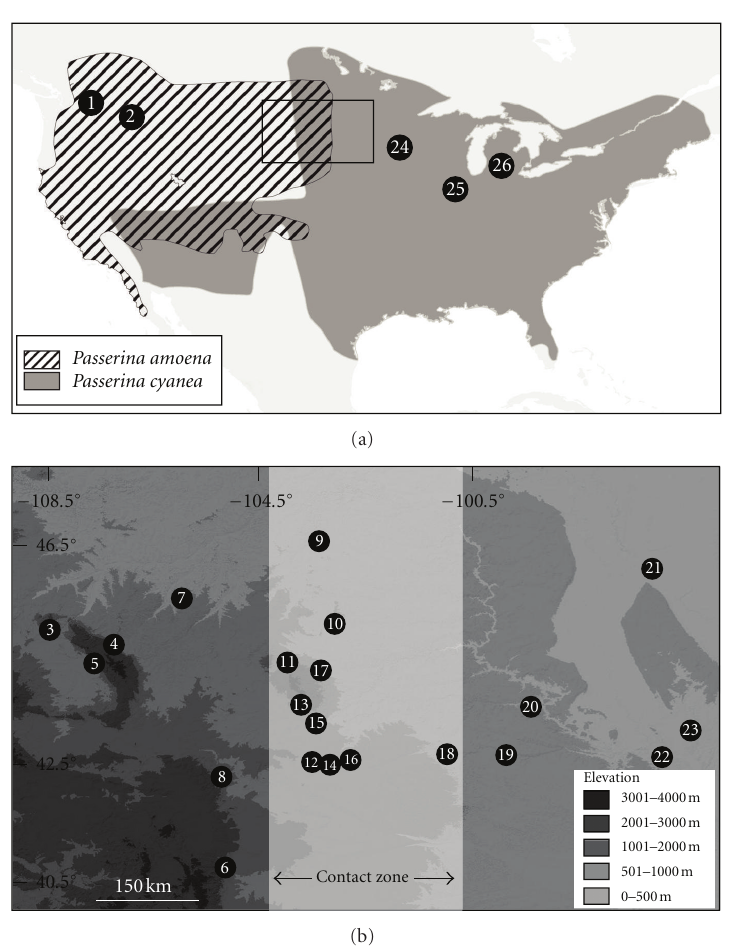
Figure 1: (a) Primary breeding distributions and allopatric sampling localities of Passerina amoena and Passerina cyanea . Area outlined by the black box is enlarged in (b). (b) Sympatric and parapatric sampling localities analyzed in this study. Background shading represents elevation and white box indicates approximate location of the sympatric contact zone. See Table 1 for more detailed information on sampling localities. Digital maps for each species [31] were downloaded from NatureServe [32] and